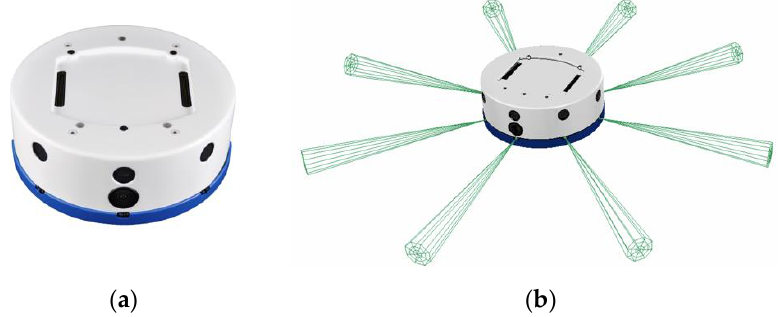
Figure 5. Mobile Robot Khepera IV: ( a ) real robot [37], ( b ) simulated robot.